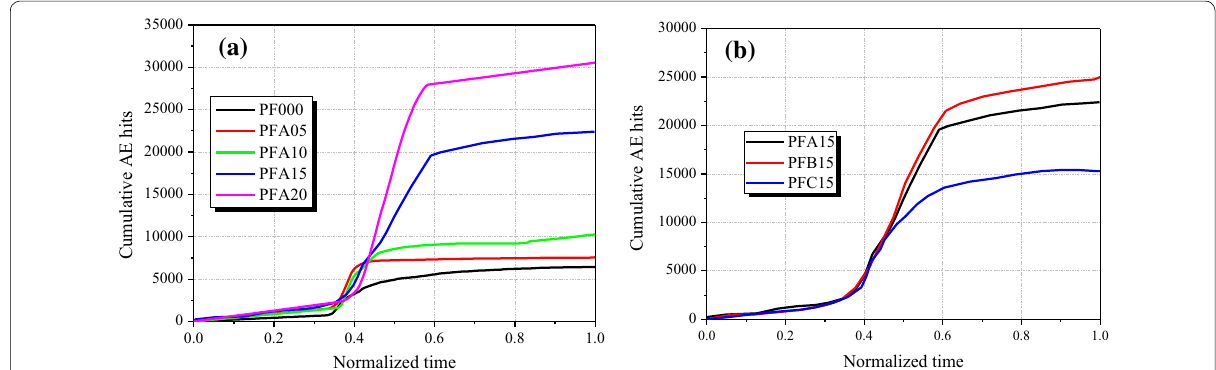
Fig. 15 Cumulative AE hits for PFRC under monotonic loading. a Effect of fiber volume fraction. b Effect of fiber aspect ratio.